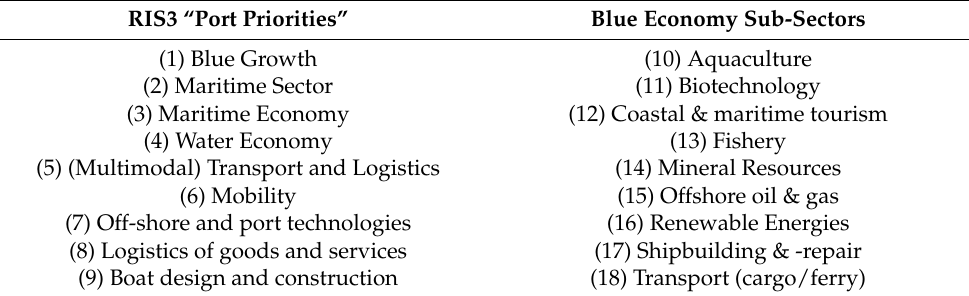
Table 1. Overview of priorities for document